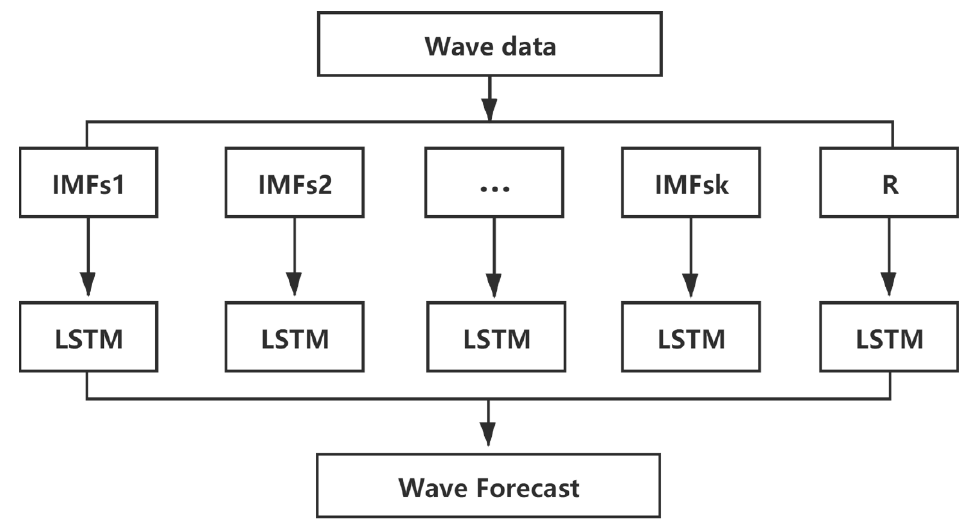
Figure 5. The joint EMD-LSTM model flowchart.